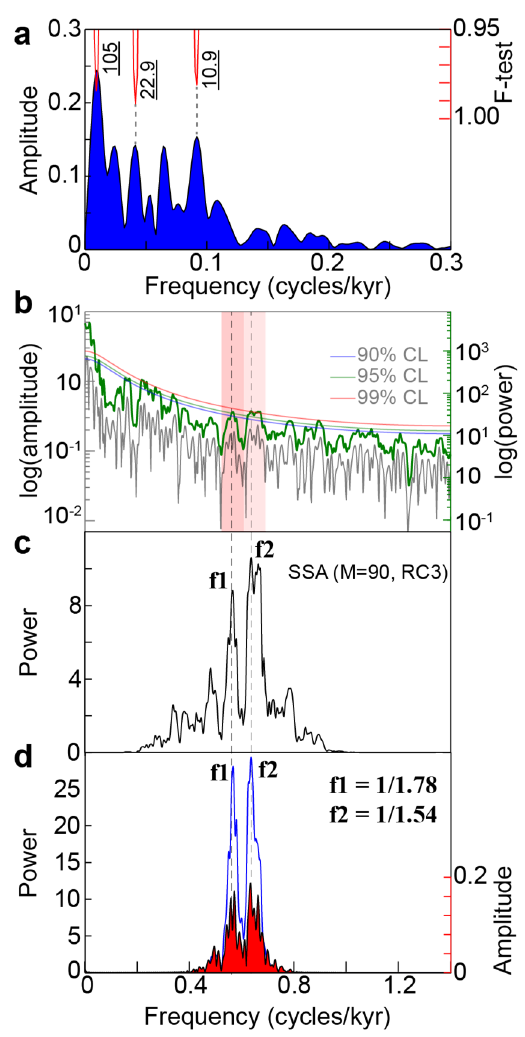
Figure 9. Amplitude and power spectra of NGRIP δ 18 O data. (a) Amplitude spectrum of AM of the 1.5 kyr band (red curve in Fig. 8d). (b) Amplitude and power spectra of the raw δ 18 O data (curve in Fig. 8a). (c) Power spectrum of SSA RC3 (green curve in Fig. 8c). (d) Amplitude and power spectra of the 1.5 kyr bandpass filtered δ 18 O data (black curve in Fig. 8d). The vertical dashed lines indicate the two beating frequencies f1 and f2 producing the 10.9 kyr period shown in the upper panel in